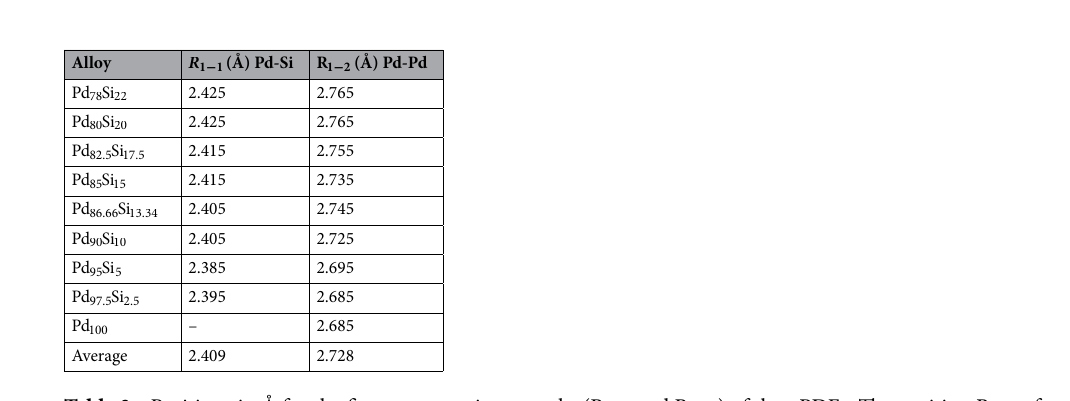
Table 3. Positions in Å for the first two prominent peaks (R 1 − 1 and R 1 − 2 ) of the pPDFs. The position R 1 − 1 of the simulated first-neighbor is, on average, 2.41 Å; the experimental value is 2.4 Å 19 .